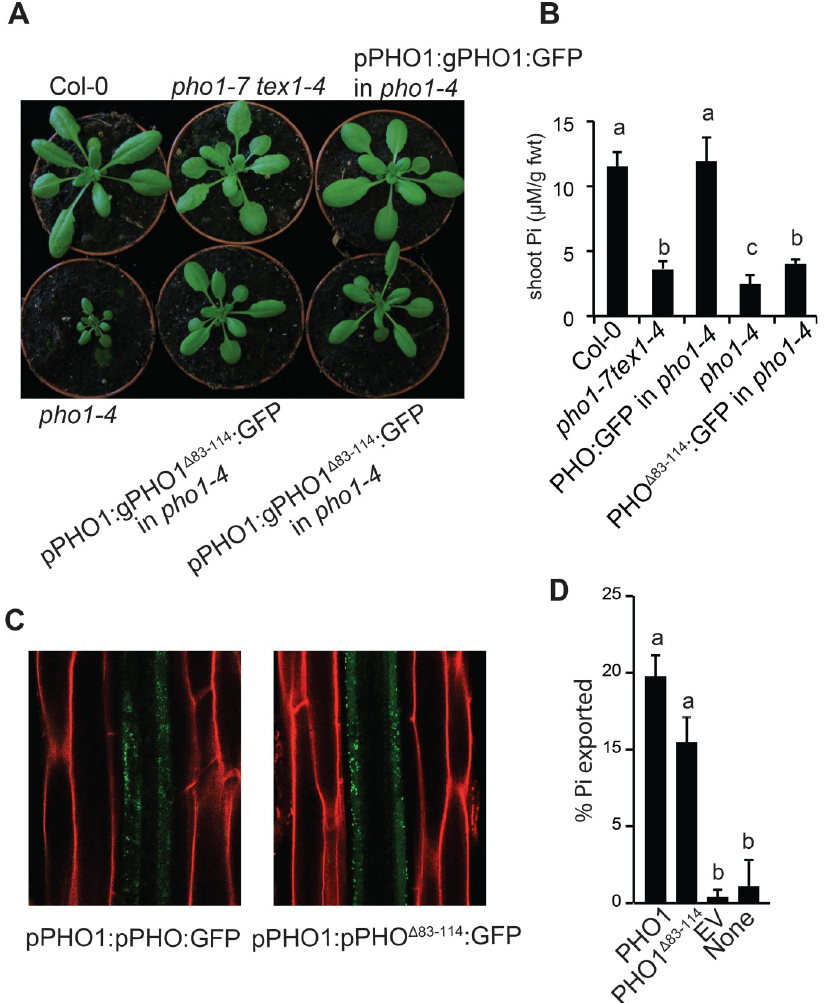
Fig 3. Truncated PHO1 Δ 84–114 is sufficient to restore the shoot growth phenotype of pho1-4 null mutant. (A) Phenotype of four-week-old plants. (B) Pi contents in the rosettes of 4-week-old plants. Data from a representative experiment shows the means of Pi contents from six individual plants grown in independent pots. Error bars represent standard deviation. (C) Localization of full-length PHO1:GFP and PHO1 Δ 83–114 :GFP in the roots of 7-day-old seedlings. Both PHO1 : GFP and PHO1 Δ 83–114 : GFP were expressed under the control of native PHO1 promoter in the pho1-4 null mutant. (D) Pi export mediated by PHO1:GFP and PHO1 Δ 84–114 : GFP from transient expression in N . benthamiana leaf discs. As controls, Pi export was measured in leaf discs expressing either free GFP (EV) or not infiltrated (none). Data are means of 4 measurements taken from independent infiltrated leaves. Error bars represent standard deviation. For B and D, values marked with lowercase letters are statistically significantly different from those for other groups marked with different letters. (P < 0.05, ANOVA with the Tukey-Kramer HSD test).